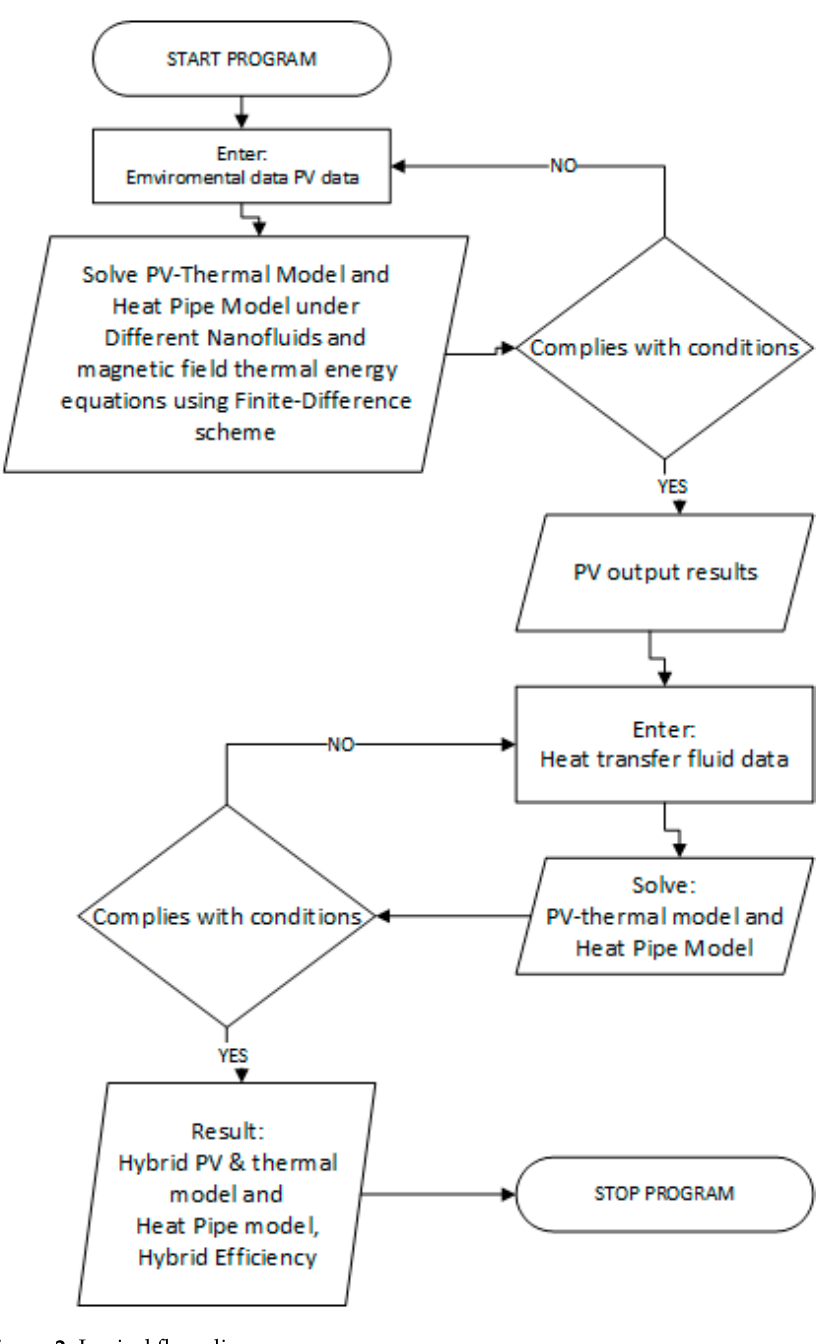
Figure 2. Logical flow diagram.